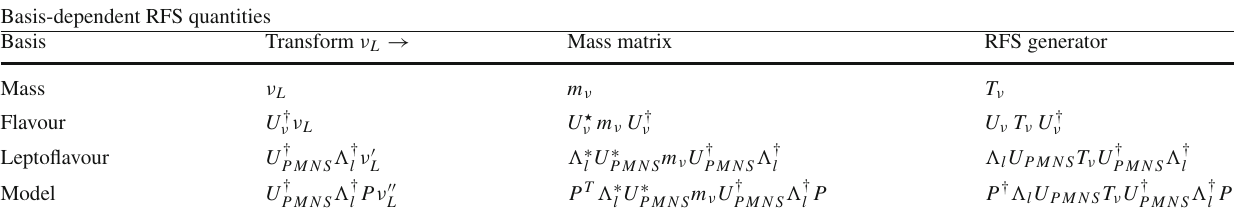
Table 3 The RFS generators associated with a given basis change away from the original mass-eigenstate ν L Basis-dependent RFS quantities Basis Transform ν L → Mass matrix RFS generator Mass ν